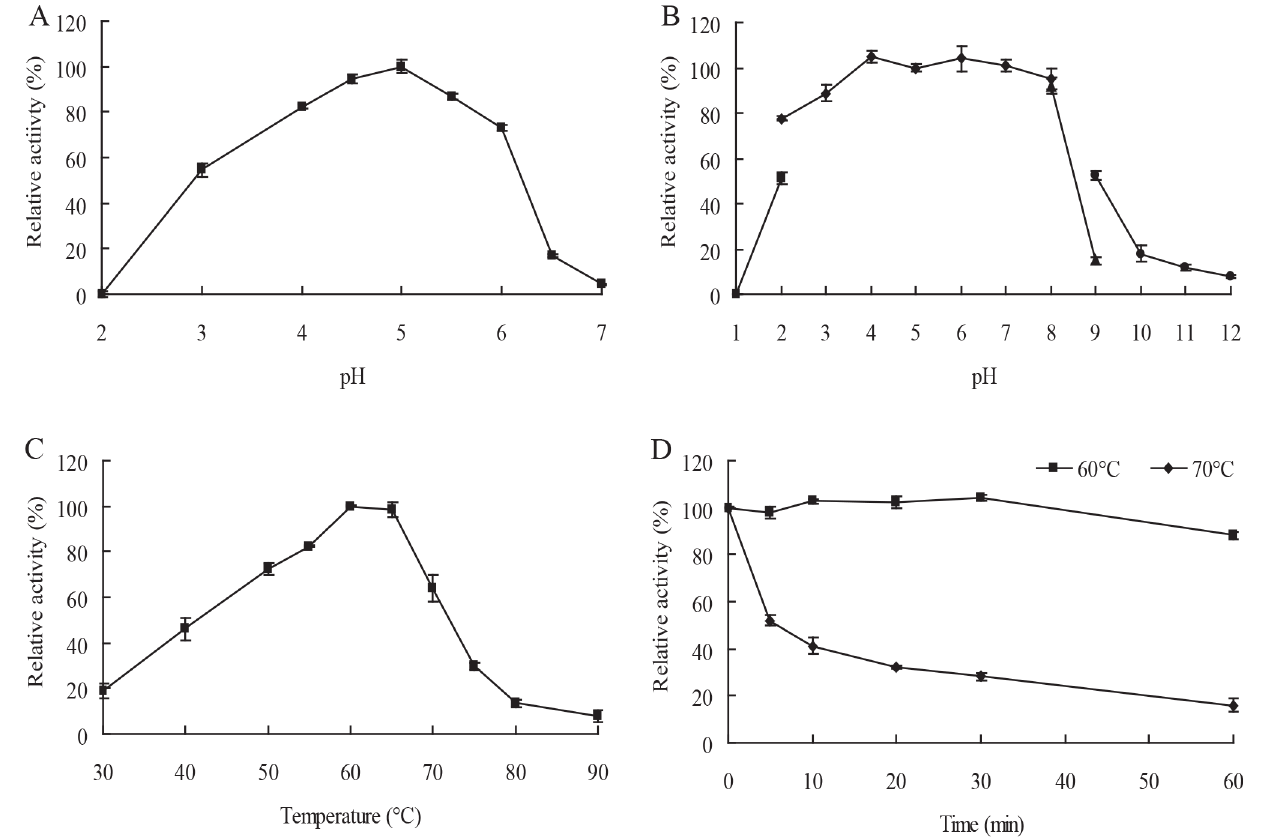
Fig 2. Characterization of purified recombinant Cel7A. ( A) Effect of pH on enzyme activity assayed at 60°C. ( B) pH stability. The enzyme activity was assayed after 1-h incubation at 37°C and different pH values. ( C) Effect of temperature on enzyme activity at optimal pH. ( D) Thermostability assay at 60°C and 70°C. Each value in the panel represents the means ± SD ( n = 3).